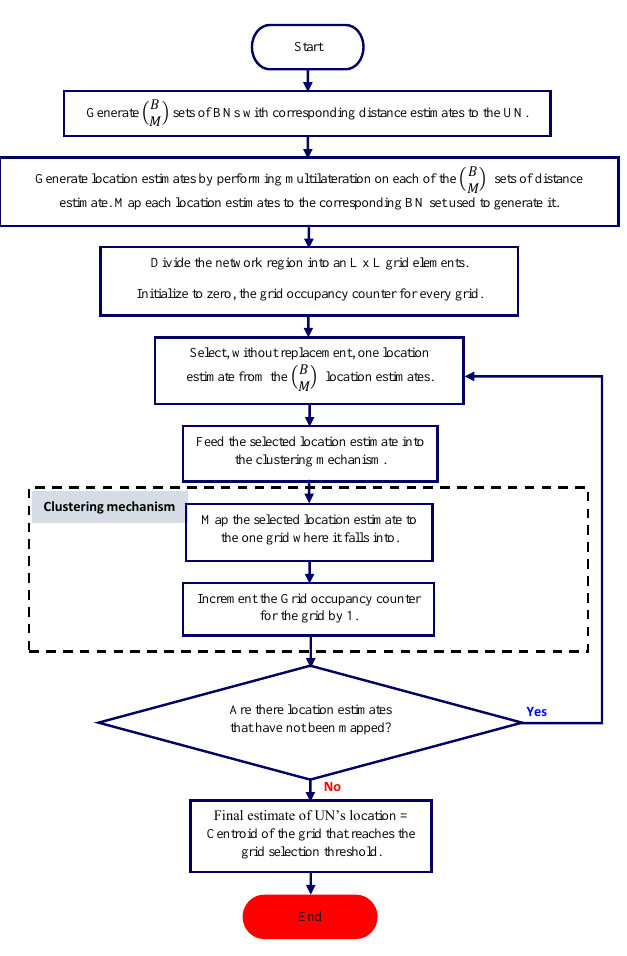
Figure 10. OD_CTRD Outlier detection localization scheme